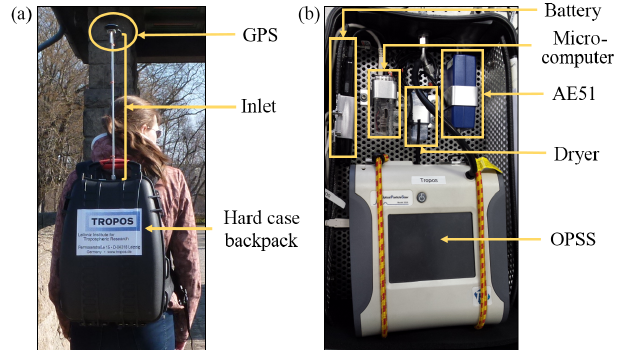
Figure A1. The TROPOS aerosol backpack from the outside (a) showing the GPS unit, inlet, and entire backpack; and from the inside (b) showing the different components and main instruments: AE51 and OPSS. Image source: TROPOS